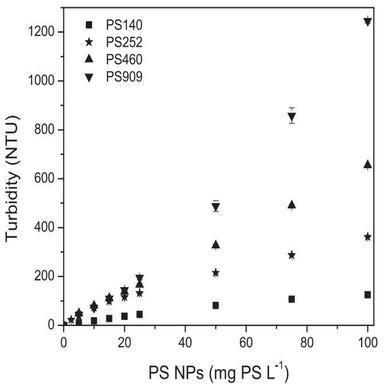
Calibration curves of turbidity vs. PS NPs concentration ( = 0 − 100 mg/L and D0 = 140, 252, 460 and 909 nm).